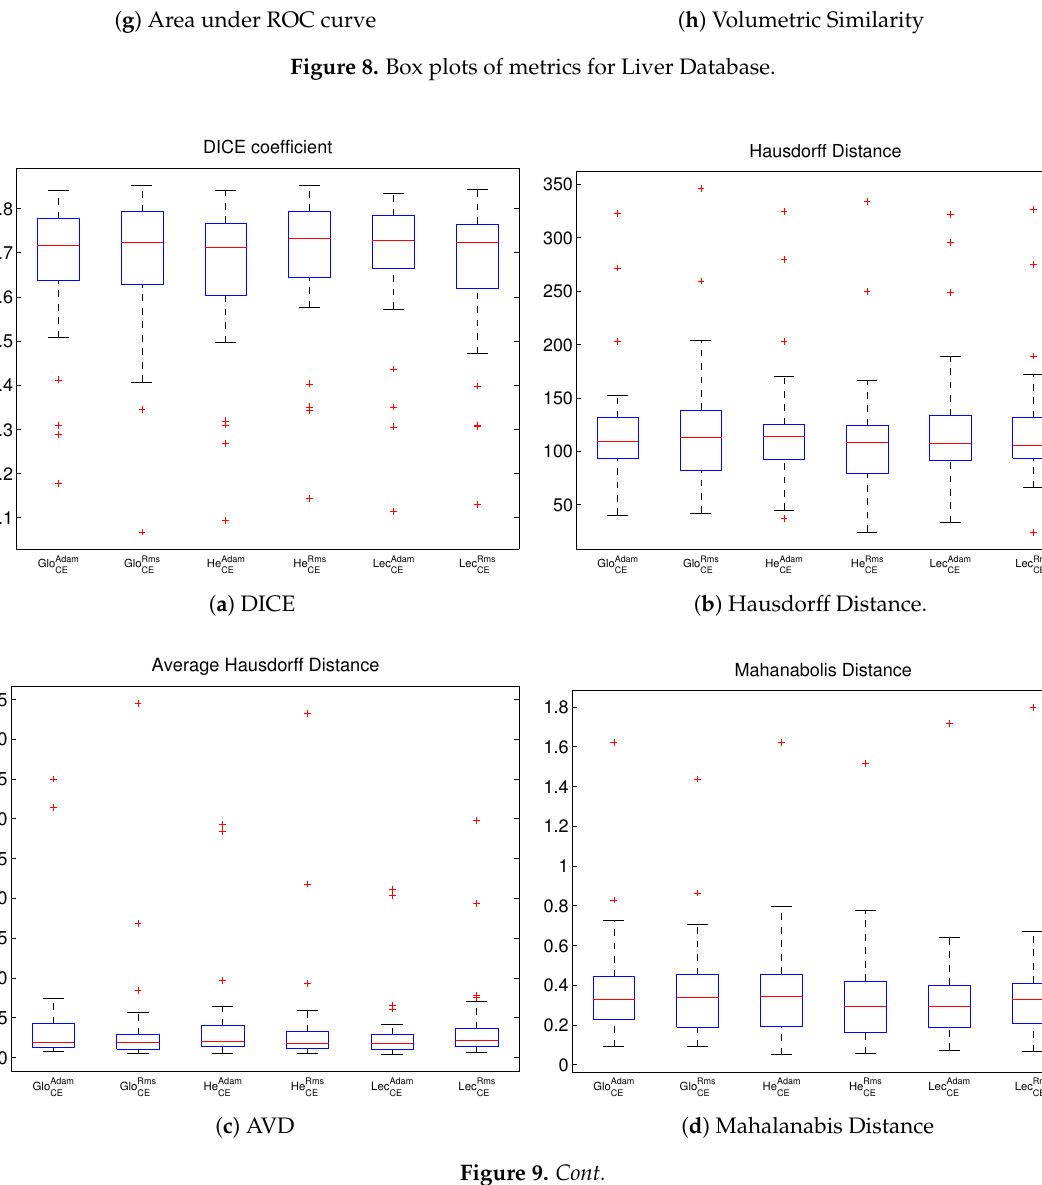
Figure 8. Box plots of metrics for Liver Database.